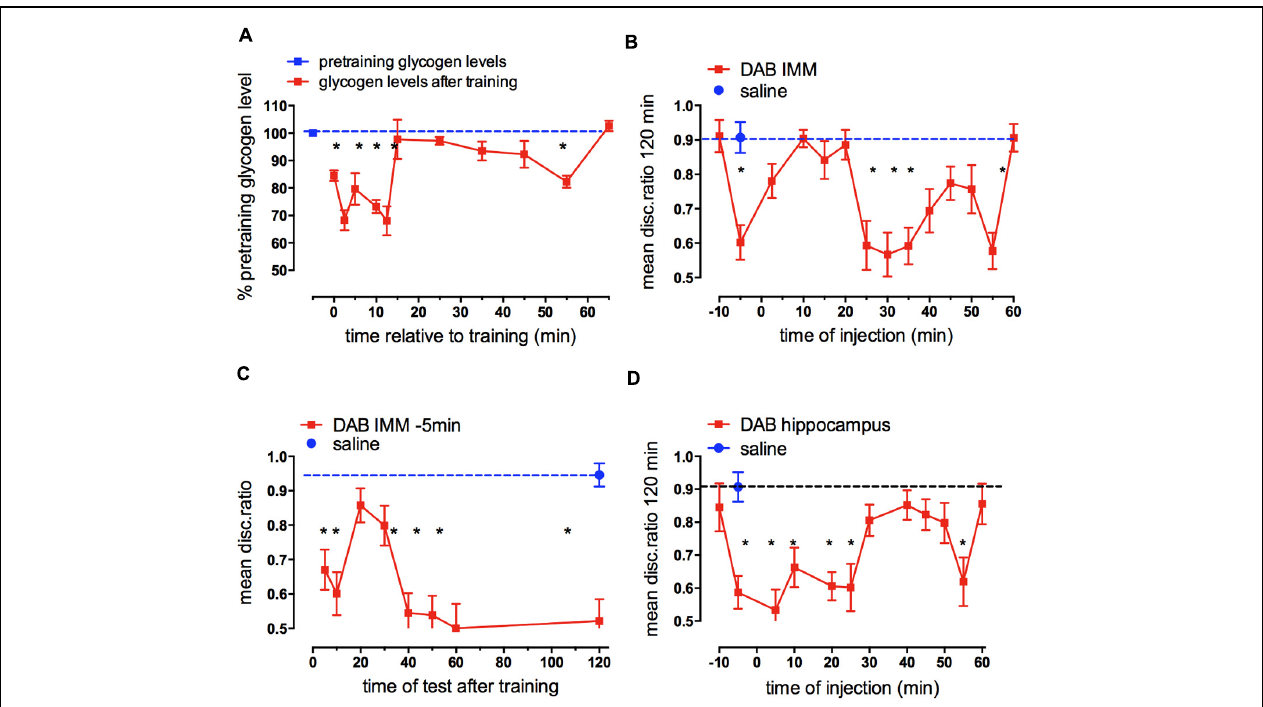
FIGURE 3 | Glycogen levels after training in chick forebrain and effect on memory consolidation of inhibition of glycogen breakdown. (A) Glycogen levels in combined left and right hemispheres after training compared with the glycogen content at pre-training. Glycogen was measured as described by Lo et al. (1970) with minor modifications. Brains were excised and transferred to pre-weighted tubes and their weight determined by the increase in weight. After digestion of the tissue, glycogen was precipitated by the addition of 95% ethanol, hydrolyzed to glucose in a phenol-sulphuric acid solution and the absorbance measured at 490 nm and calibrated by aid of a standard glucose curve (From O’Dowd et al., 1994; Hertz et al., 2003). (B) Times of injection of DAB into IMM after strongly reinforced training showing those times at which memory processing requires glycogen breakdown; (C) Times of test after strongly reinforced training following DAB injection 5 min before training revealing when memory is affected by DAB; (D) Times of injection of DAB into the hippocampus following strongly reinforced training. (From Gibbs et al., 2007, 2008b). In this figure and all subsequent graphs the dashed line represents saline control value for strongly reinforced training (high DR) or weakly reinforced training (DR approaching 0.5) * P <